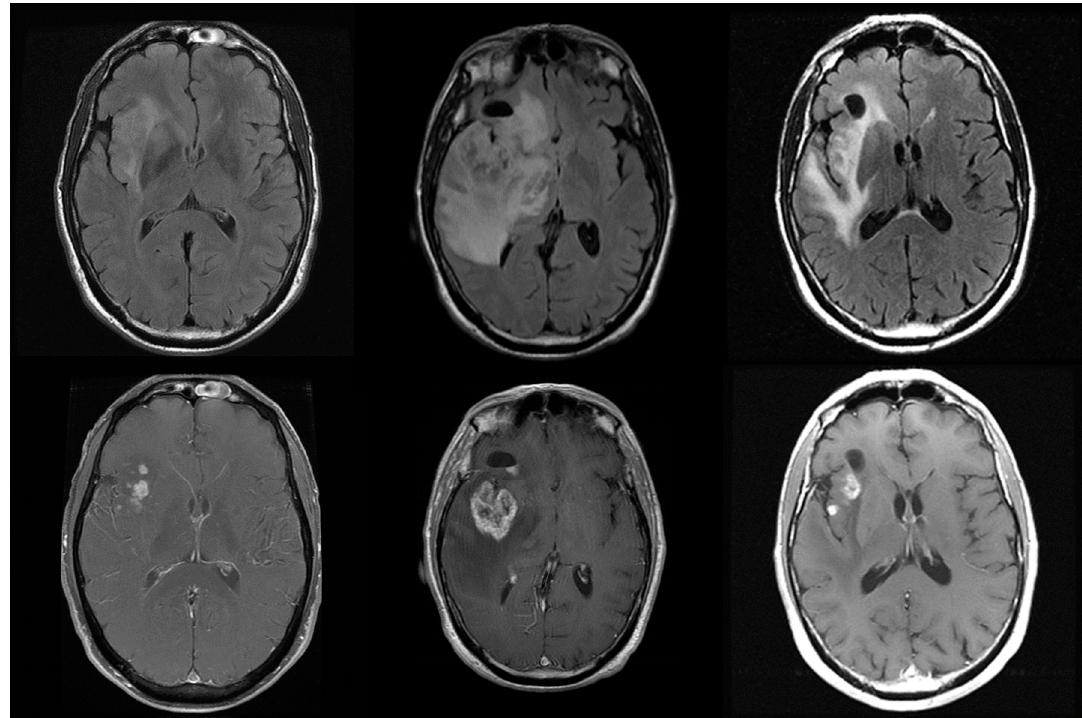
Figure 1. Glioblastoma (WHO IV) patient at presentation (left), shows an insular tumor with islands of enhancement. Following 60 Gy of radiation with Temozolamide 75 mg/m 2 daily (middle column), there is an apparent increase in both enhancement and edema with mass effect. These worsened imaging findings resolve one month later with Decadron 6 mg twice daily, with a near return to imaging baseline. This apparent worsening on imaging is known as pseudoprogression and represents an inflammatory response to therapy that is difficult to distinguish from true progression. Pseudoprogression complicates the imaging and clinical management of glioma